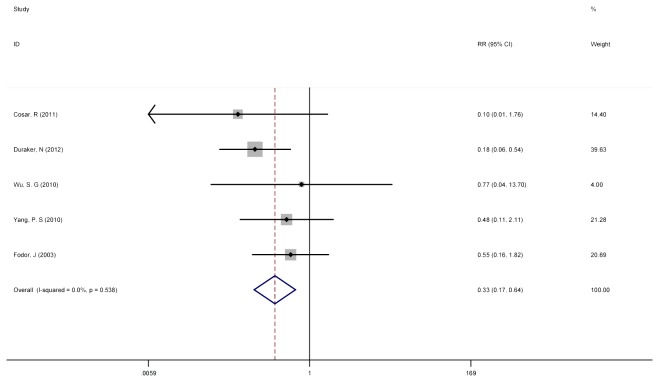
No PMRT versus PMRT after mastectomy surgery for the T1/N1-3+ subgroup on LRR.Five studies with detailed information were involved to investigate the role of PMRT in T1/N1-3+ patients. The pooled RR for LRR in patients with PMRT was 0.330 (95% CI = 0.171 to 0.639), and significant heterogeneity (Cochran’s p = 0.539; I2 = 0.00%) was not detected between the 5 studies included in this portion of the meta-analysis [11,12,17,19,23].